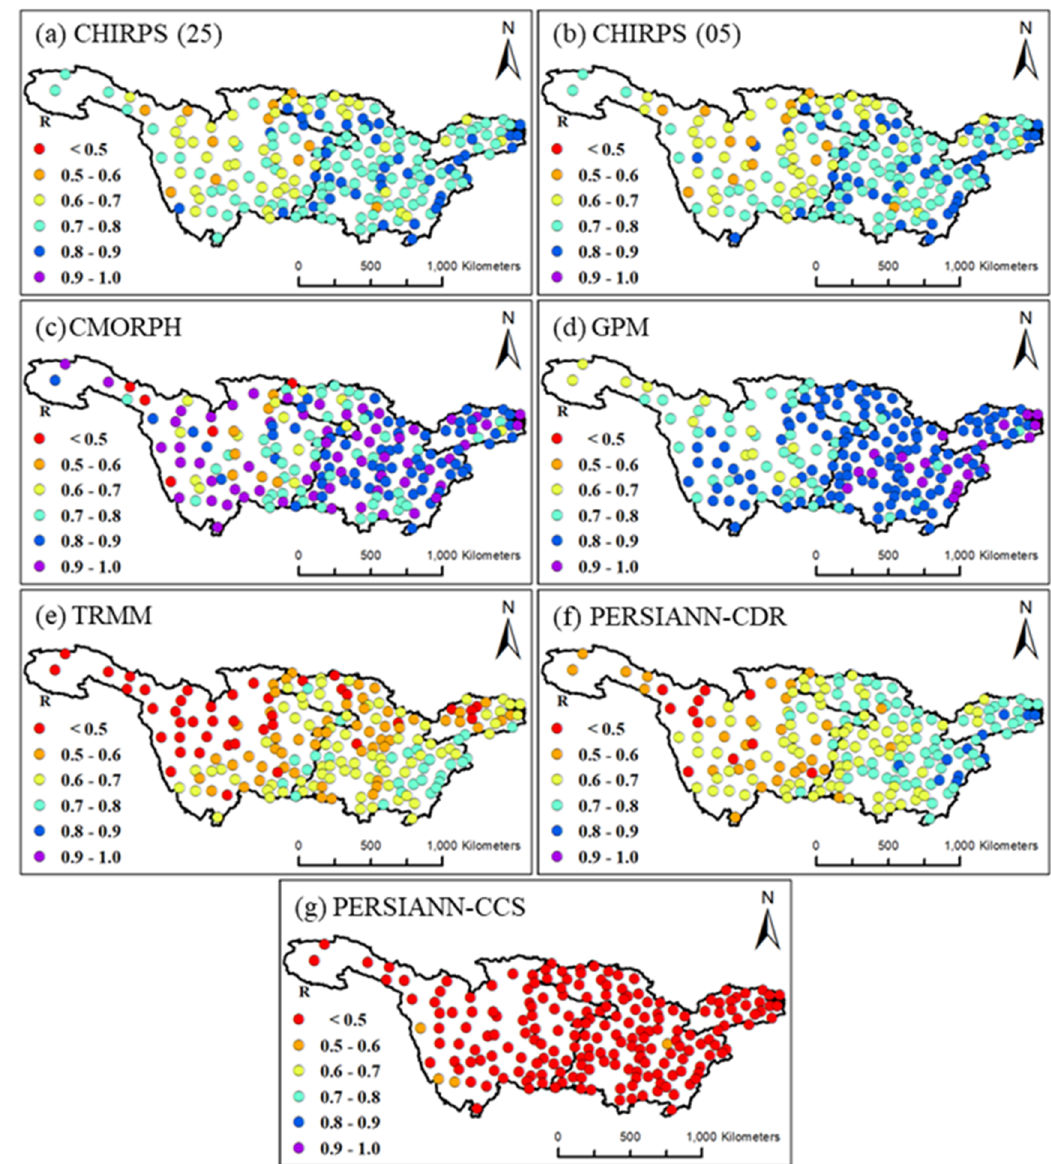
Figure 8. The spatial distributions of R values between the SPI–3 time series given by the meteorological stations and seven SPPs,